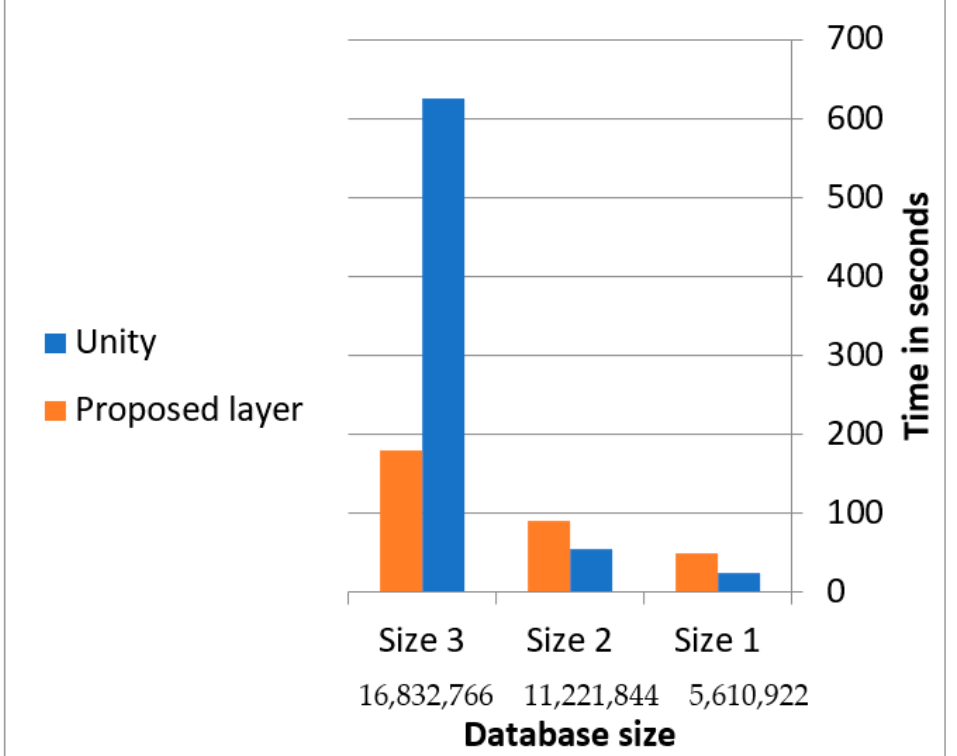
Figure 7. Elapsed time comparison between Unity and the proposed layer.